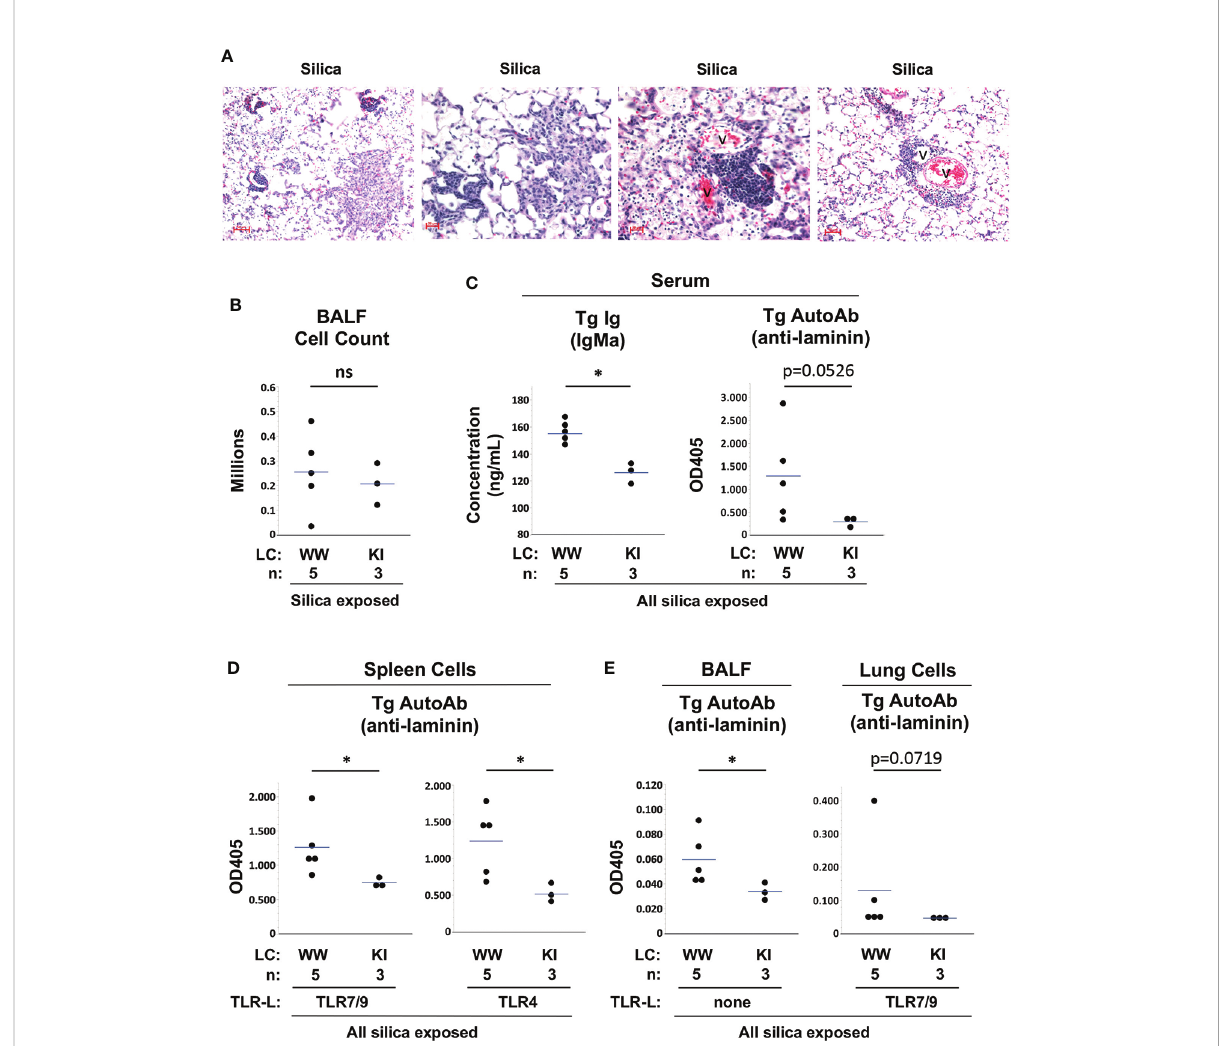
FIGURE 5 Lung in fl ammation and autoantibody production in silica-exposed M7 Tg/WW versus M7 Tg/KI mice. (A) Representative sections of lungs from 3 different M7 Tg/KI mice exposed to silica by oropharyngeal aspiration at 5 to 6 weeks prior to organ harvest; H&E; v = blood vessel. (B) Leukocyte count in bronchoalveolar lavage fl uid (BALF). (C – E) Transgene IgMa concentration and anti-laminin IgMa autoantibody levels in (C) serum, (D) supernatants of spleen cell cultures, and (E) BALF and supernatants of lung cell cultures. Antibody levels were determined by ELISA for samples in duplicate using undiluted BALF and culture supernatants and serum diluted 1/20 for anti-laminin Ig. Isolated spleen and lung cells were cultured with a mixture of TLR7 and TLR9 ligands (TLR7/9-L) R848 and CpG oligos. All M7 mice carry the dominant LamH Ig heavy chain Tg that encodes anti-laminin Ig. Tg/WW mice carry the wildtype (W) Ig light chain gene at both kappa loci, enabling a diverse light chain repertoire; Tg/KI mice are heterozygous for a Vk8Jk5 kappa light chain knock-in (KI) gene, restricting the expressed light chain repertoire. Each circle represents an individual mouse; the bar indicates the mean for each group; *p < 0.05; Wilcoxon rank sum